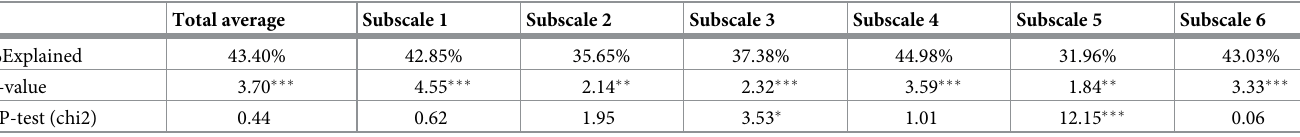
Table 8. Results of ANOVA for testing the score variations between nursery